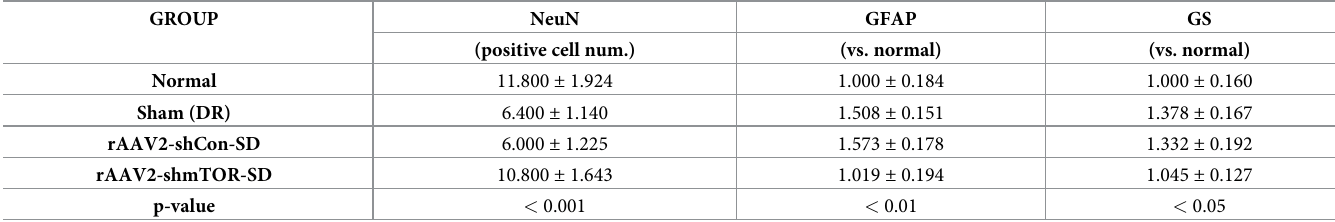
Table 1. Retinal tissue